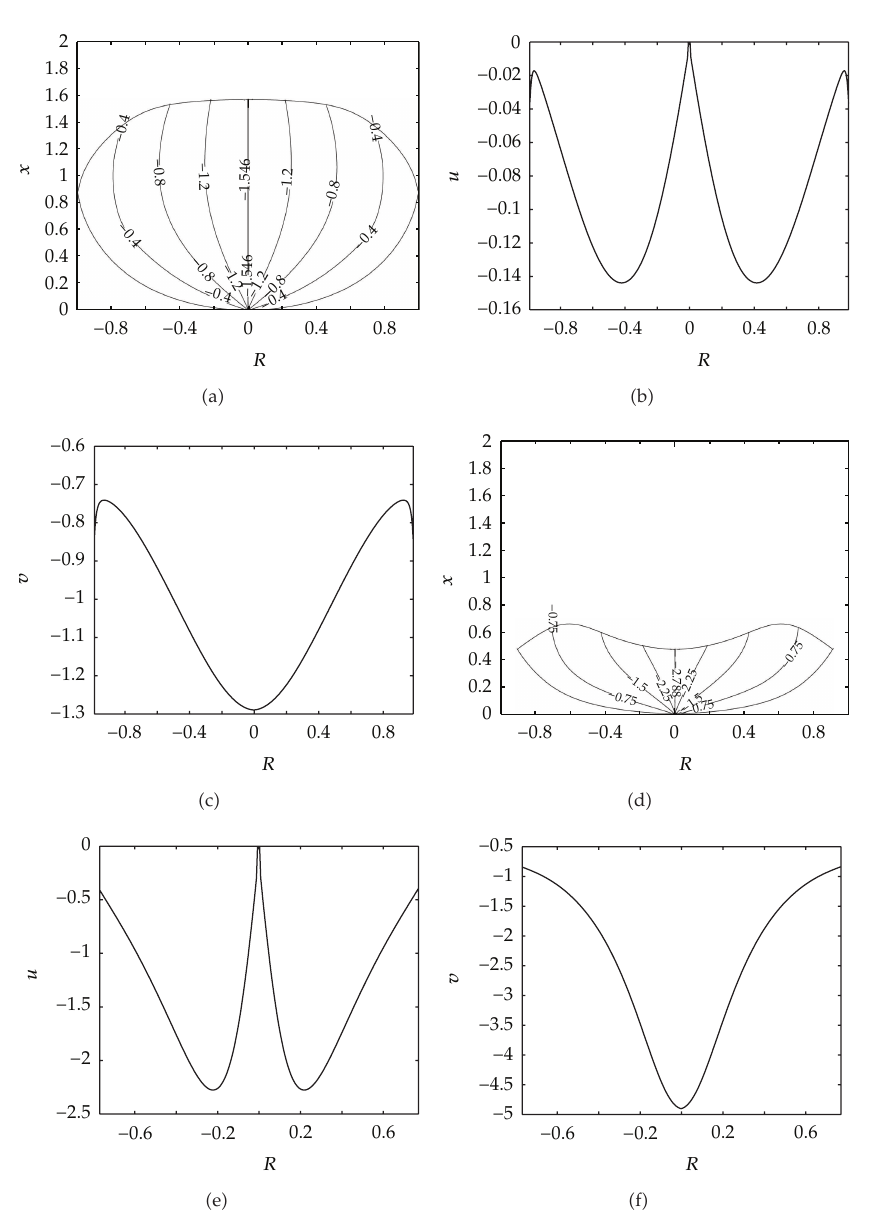
Figure 9: (cid:5) a, d (cid:6) Contour plot of the fluid motion within the modeled axisymmetric collapsing vessel during micturition. Also plotted are the horizontal (cid:5) b, e (cid:6) and vertical (cid:5) c, f (cid:6) velocities along the horizontal